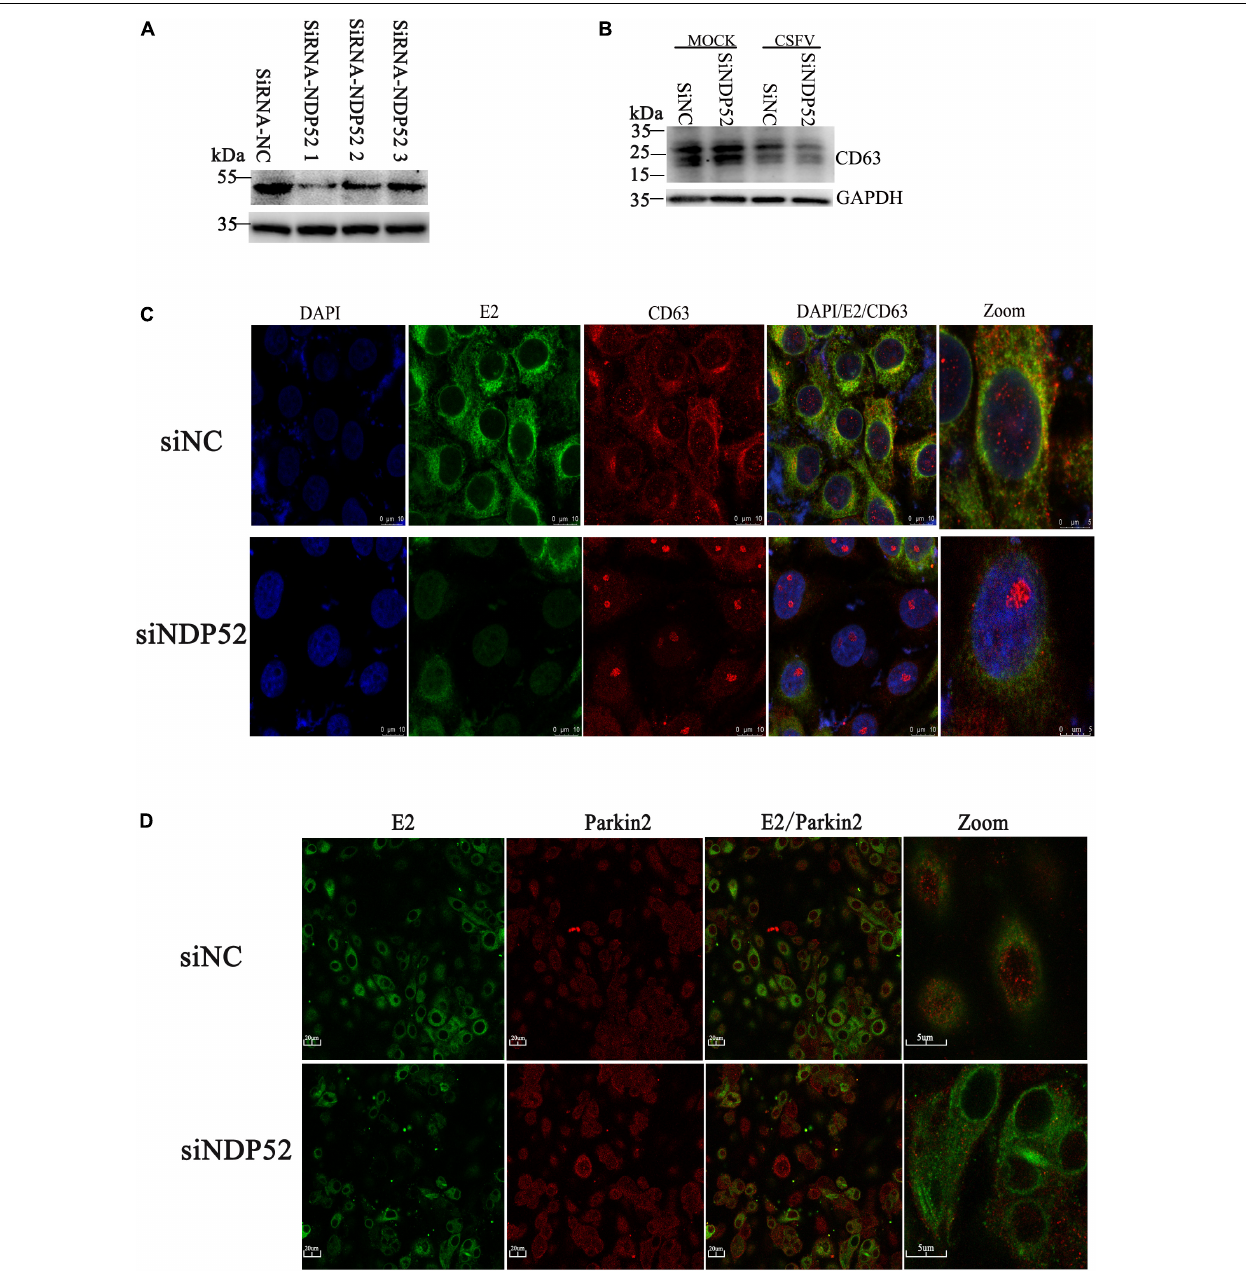
FIGURE 5 | Inhibition of NDP52 reduces CD63 and Ub(A-5) binding to E2. (A) Three different NDP52 interference plasmids were verified by Western blot. GAPDH was used as the internal loading control. siRNA-NDP52-1 was used to inhibit NDP52 expression for subsequent experiments. (B) PK-15 cells were transfected with scrambled or NDP52 siRNA for 24 h, followed by mock or CSFV infection (MOI = 0.1). CD63 protein expression was detected by Western blot. GAPDH was used as the internal loading control. (C) Treated PK-15 cells were immunostained with antibodies against CSFV E2 (green) and CD63 (red). (D) PK-15 cells were immunostained with antibodies against CSFV E2 (green) and Ub(A-5) (red).